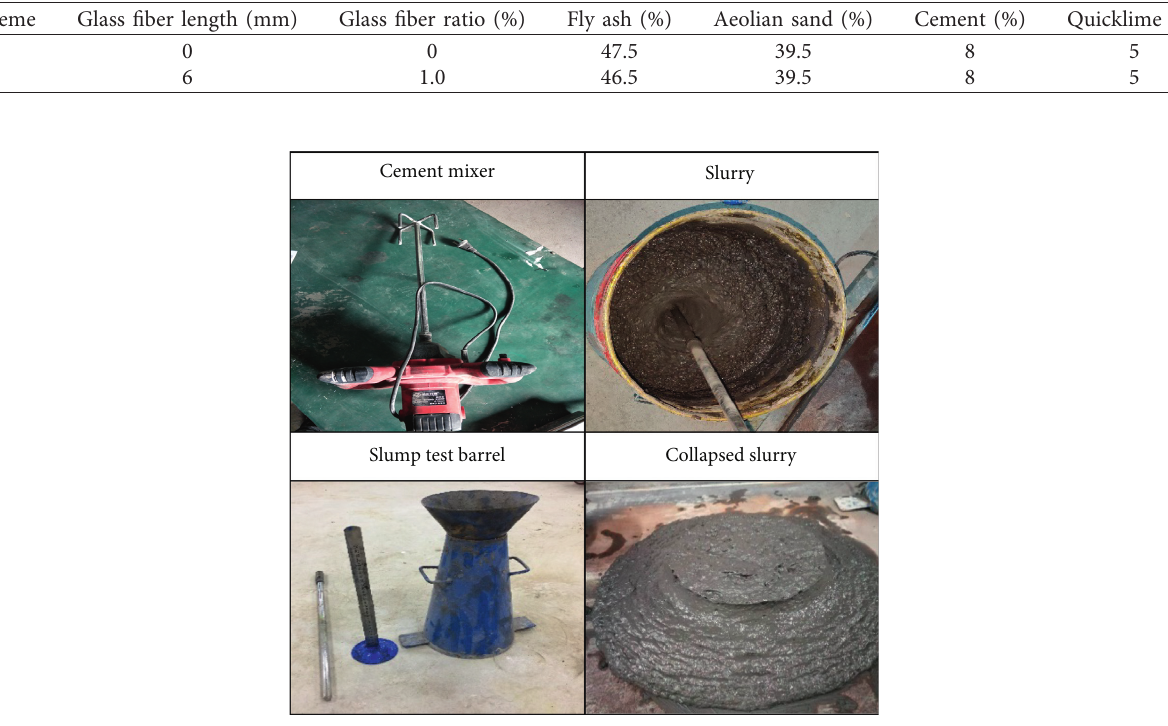
Figure 5: Transportability